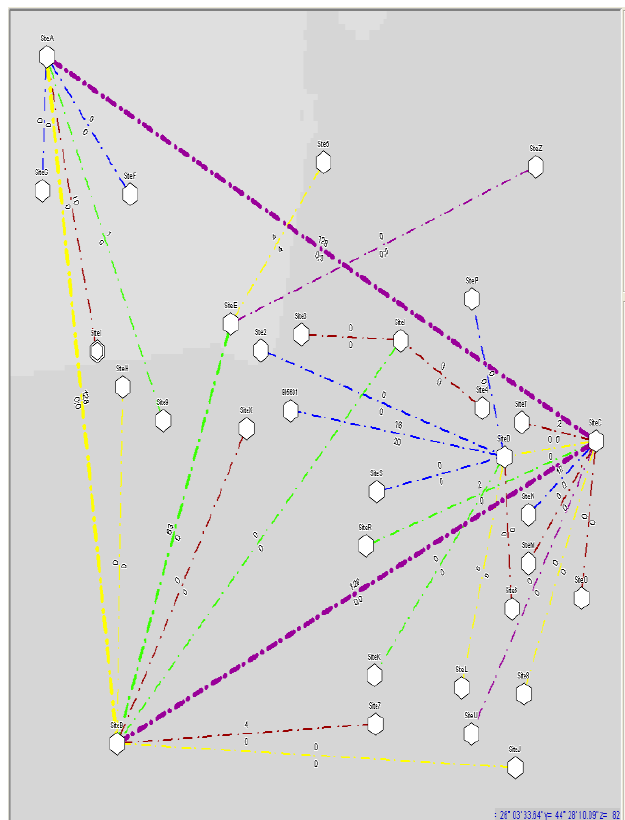
Figure 4. The projected radio Ethernet relay network in